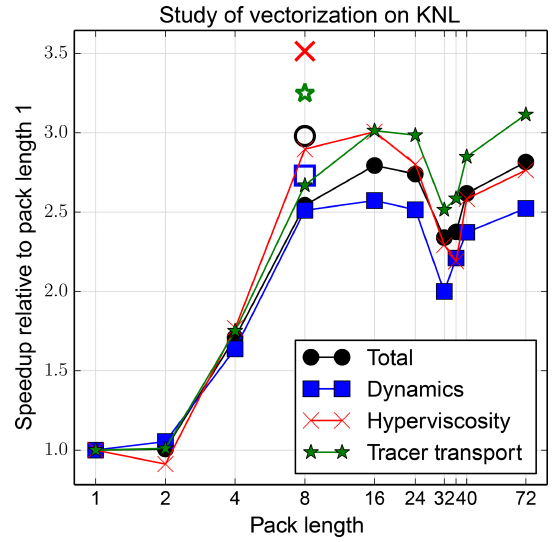
Figure 7. Study of vectorization performance on KNL as a func- tion of pack length. Solid lines with solid markers correspond to auto-vectorization within each pack operator overload. Open mark- ers correspond to explicit AVX512 intrinsic calls within each oper- ator